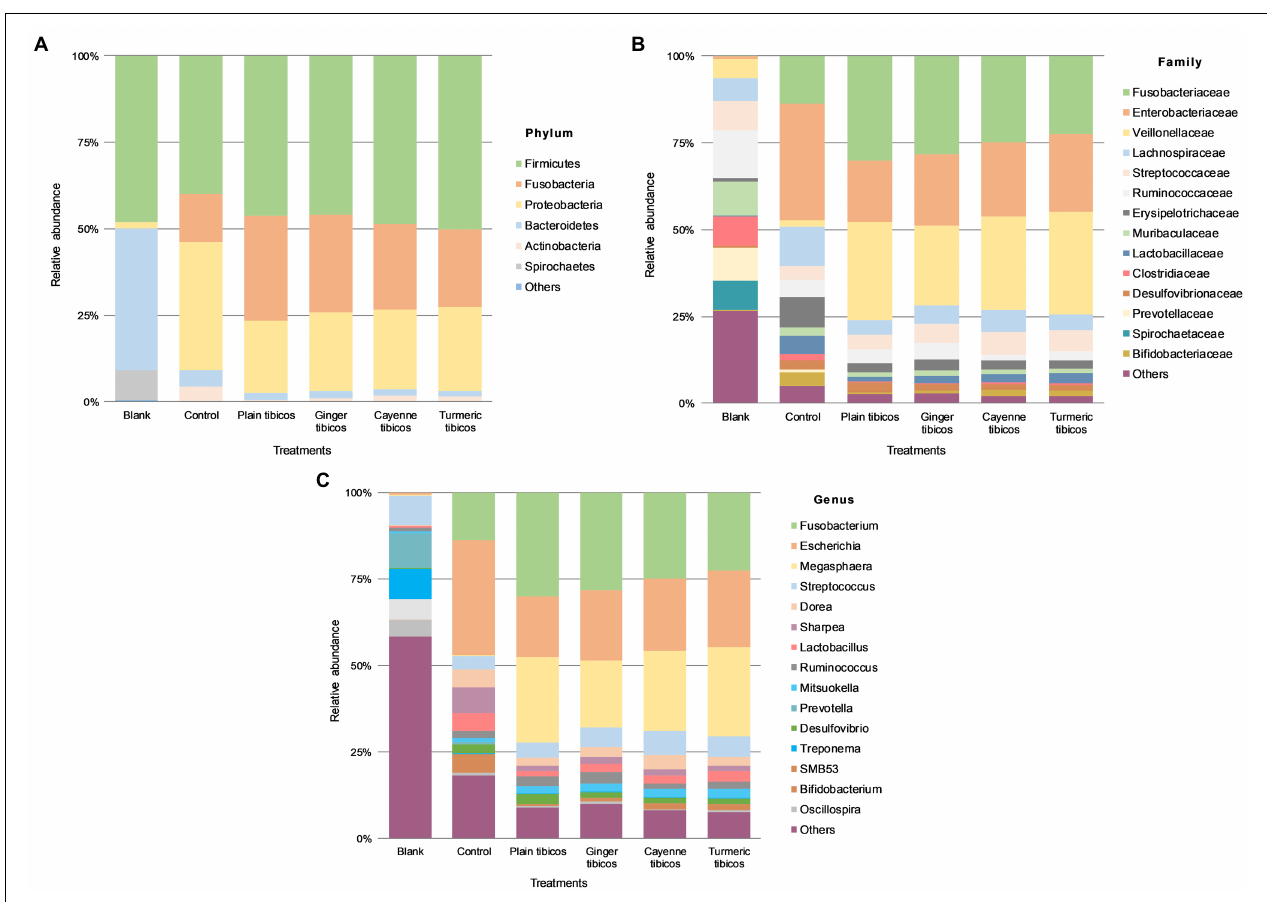
FIGURE 6 | Colonic fermentation of digested tibicos affects the final gut bacterial profile. Microbial community structures in the four tibicos treatments. Microbial taxa are characterized to the phylum (A) ; family (B) ; genus (C) levels. Dominant bacterial taxa are with greater than 1.0% relative abundance. Blank: fecal slurry with digestive fluids. Control: fecal slurry with digestive fluids post-colonic